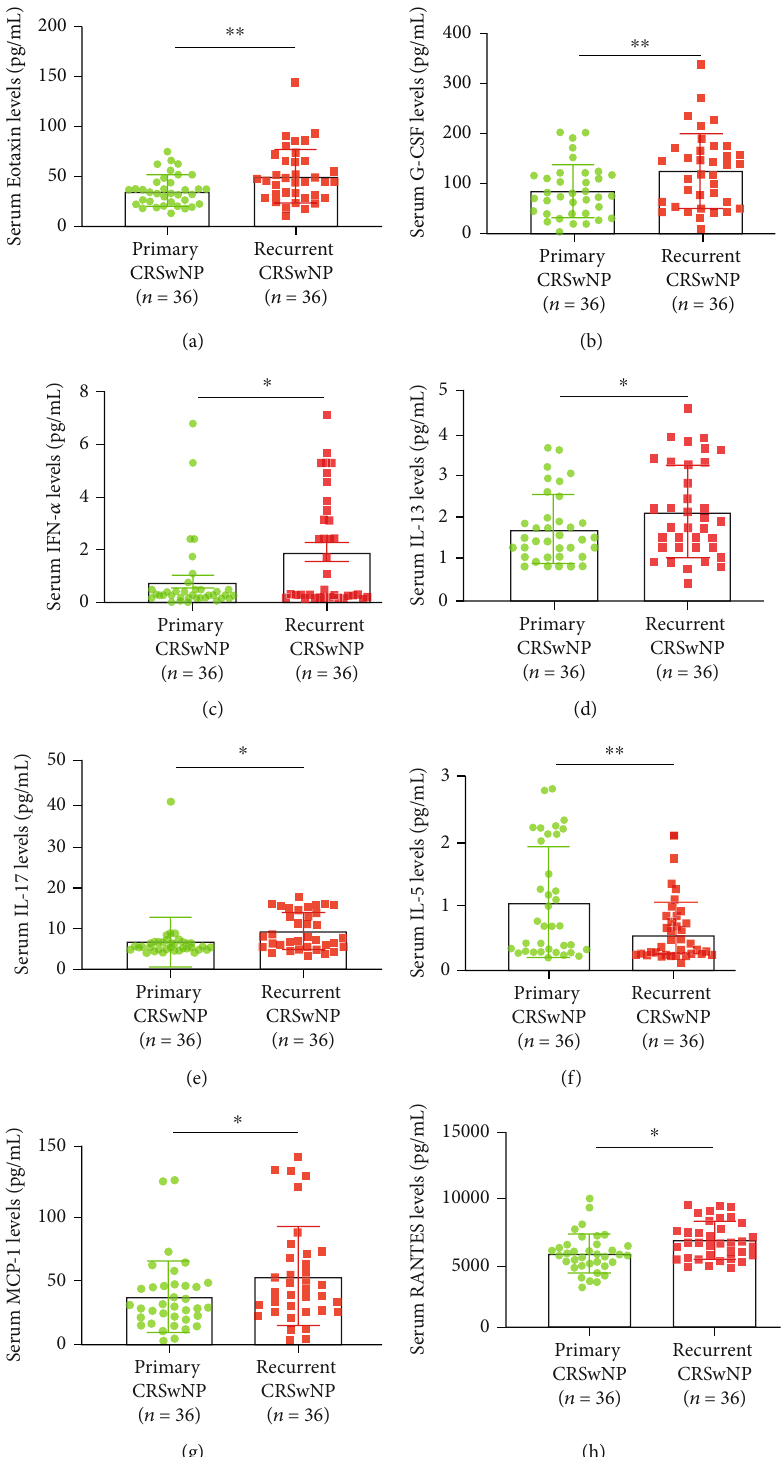
Figure 1: Serum levels of 8 cytokines were dysregulated between primary CRSwNP and recurrent CRSwNP groups based on multiple cytokine pro fi ling. CRSwNP; chronic rhinosinusitis with nasal polyps; G-CSF: granulocyte colony-stimulating factor; IFN- α : interferon alpha; IL: interleukin; MCP: monocyte chemotactic protein; RANTES: regulated upon activation normally T expressed and presumably secreted. ∗ P < 0 : 05 , ∗∗ P < 0 : 01